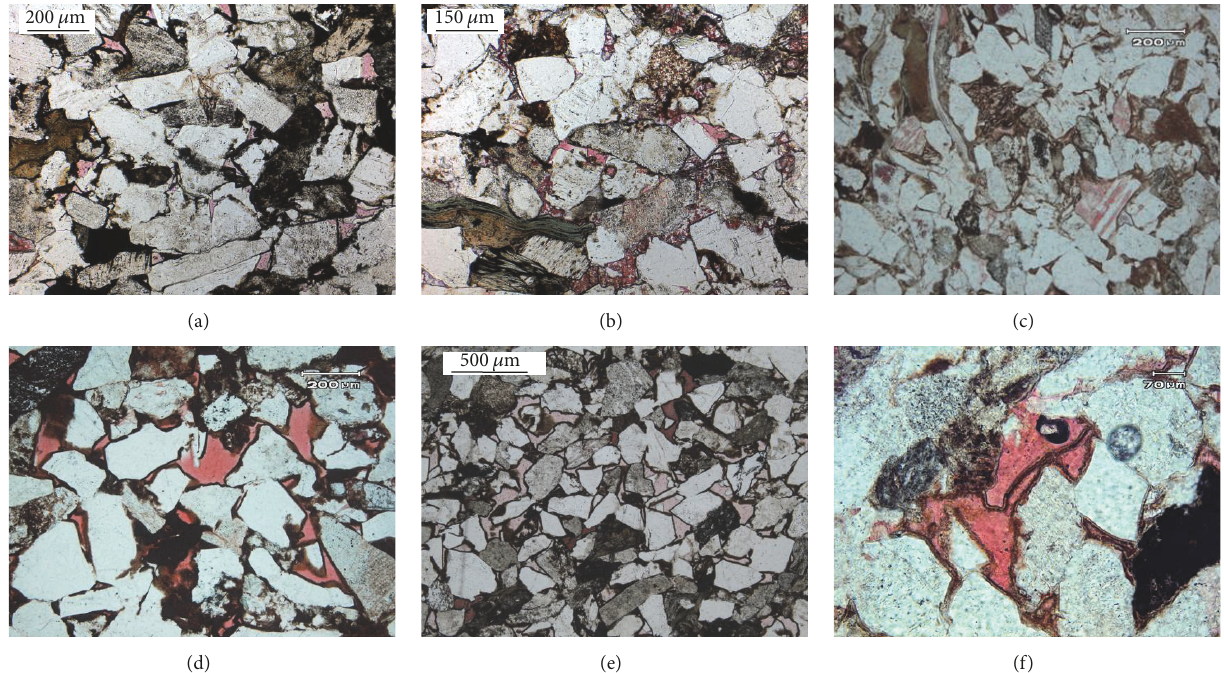
Figure 3: The lithology characteristics and reservoir pore systems of Chang 8 sandstones. (a) Medium-grained, subrounded to subangular, wellsortedsandstonegrainsexhibitplanargraincontacts,Zhuang211,1733.8 m,plane-polarizedlight(PPL);(b)medium-grained,wellsorted, frameworkgrainsareheavilycompactedduetoitsabundanceinsoftrockfragments,Zhuang211,1714.7m,PPL;(c)graincontactisdominated by concave-convex due to its abundance in soft rock fragment, Yuan 177, 2466.7 m, PPL; (d) primary intergranular pore coexisting with the moldic pore, Luo 3, 2690.75 m, PPL; (e) porosity is shown in red, with intergranular pores, Zhuang 199, 1673.81 m, PPL; (f) primary intergranular pores showing the irregular polygon morphology, Feng 2, 2433.4 m, PPL.